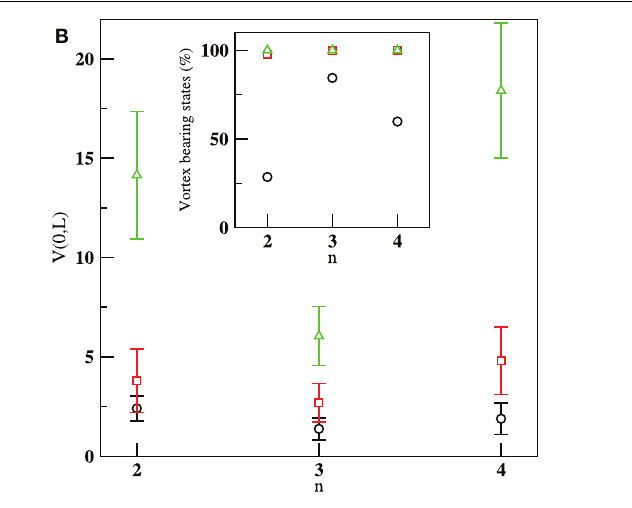
FIGURE 15 | (A) Vortex-antivortex pairs of the spin systems in the stationary state in a square lattice with size L = 64 and n = 2 with zero noise. The orientations of the spins change with time in such a way so that the entire spin pattern with vortices and the antivortices move with a uniform speed from the top-right corner to the bottom-left corner. Vortices and antivortices are marked by filled red and blue circles. (B) The number